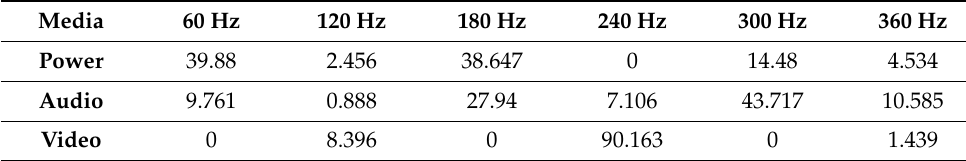
Table 1. SNR of the ENF fingerprint in media recordings.